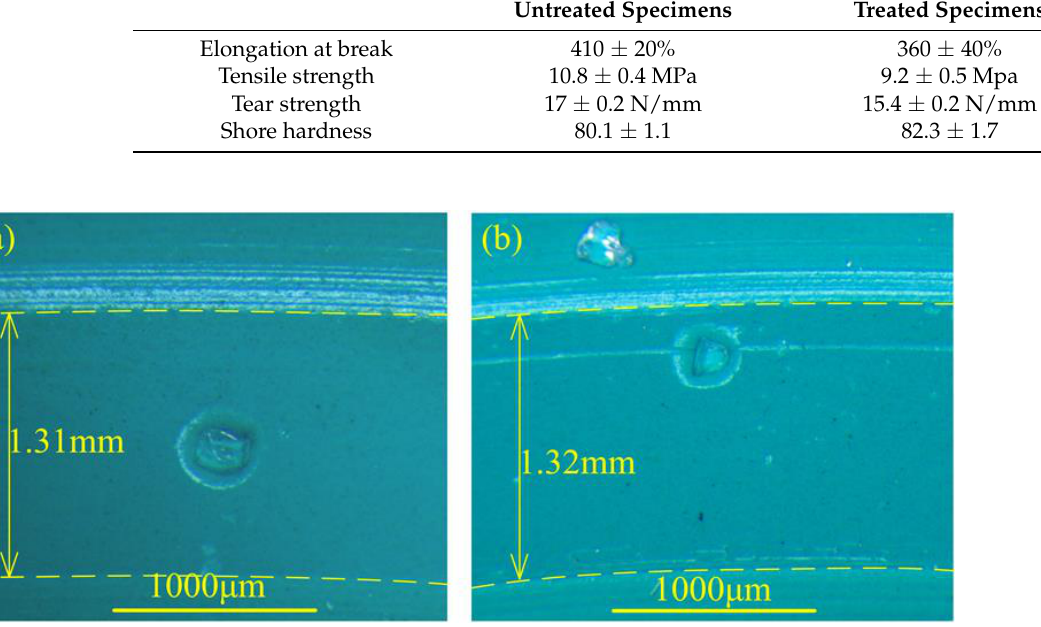
Figure 3. The optical micrograph of in situ observation of the contact area of ( a ) untreated seal and ( b ) thermally treated seal.